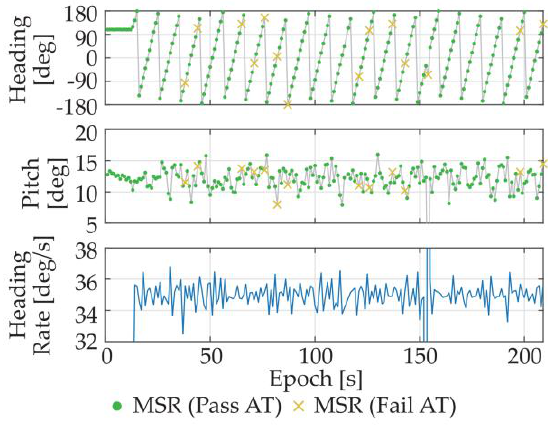
Figure 10. Attitude results of the dynamic experiment under open area.